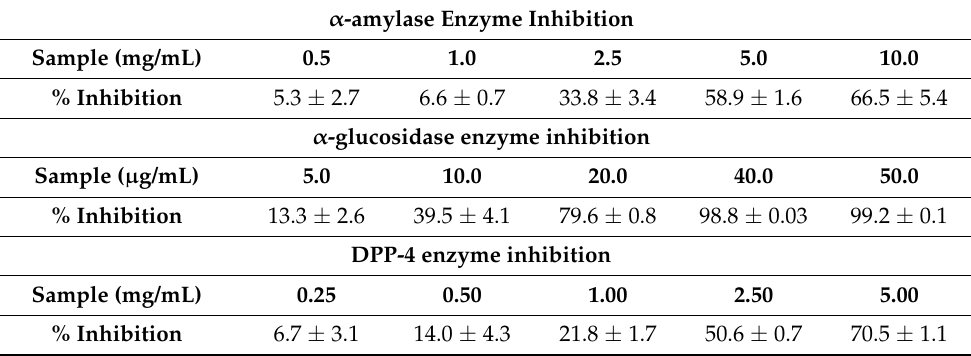
Table 1. Percentage inhibition activity of Enzogenol ® on α -amylase, α -glucosidase and DPP-4 enzymes. α -amylase Enzyme